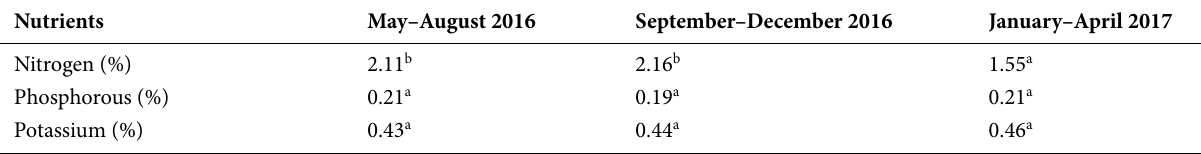
Table 2 Average nitrogen, phosphorus, and potassium content of Sidimpuan snake fruit leaves during the three flowering periods.